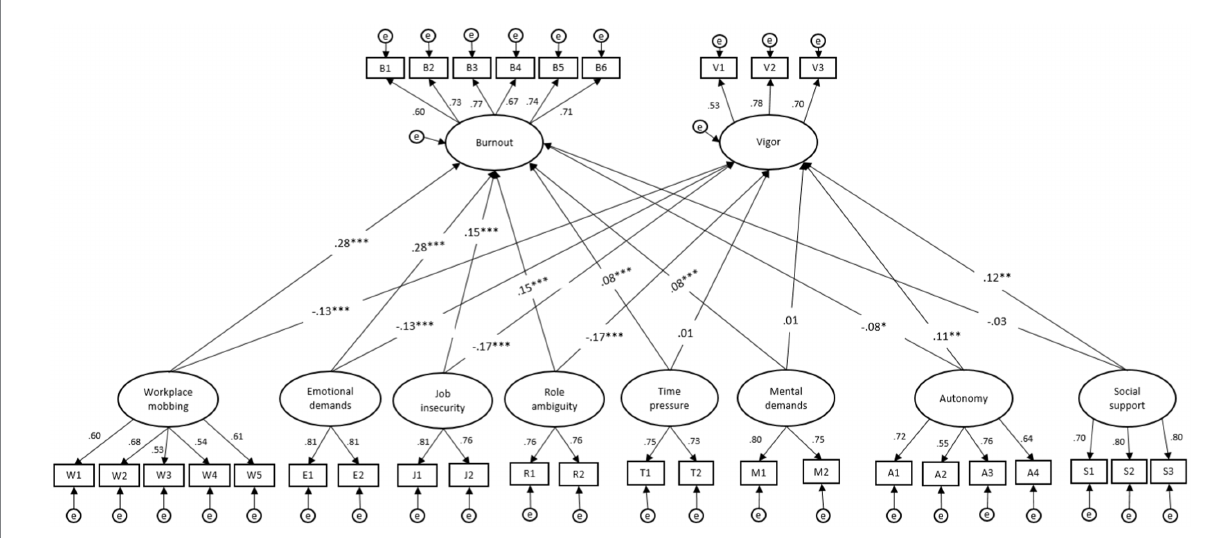
FIGURE 1 Structural model of the relationships between job threats, job hindrances, job challenges, job resources, and burnout and vigor (Model C). This structural equation model predicts employees’ burnout and vigor from threats, hindrances, challenges and job resources. χ 2 (400) = 1341.773, RMSEA = 0.040 (0.037; 0.042), SRMR = 0.043, CFI = 0.927, TLI = 0.915. Coefficients represent standardized estimates. * p < 0.05. ** p < 0.01. *** p <